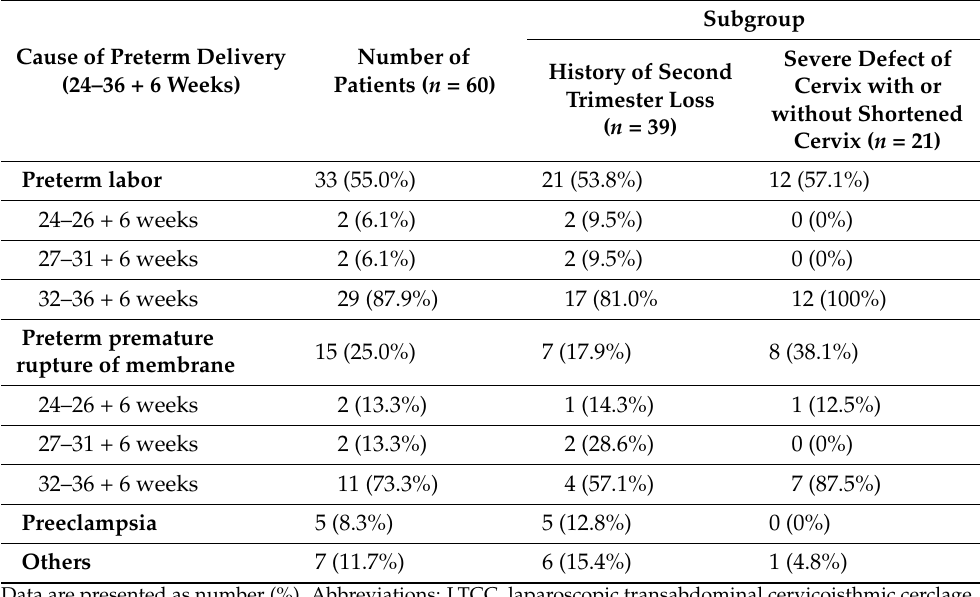
Table 4. Cause of preterm delivery after modified